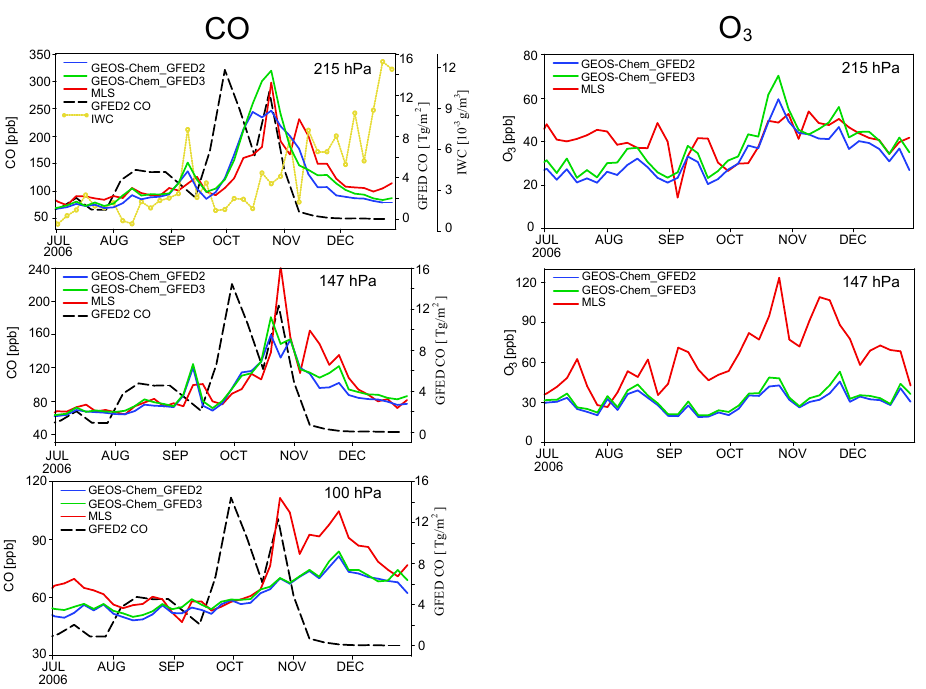
Fig. 9. Upper tropospheric CO and O 3 concentrations over the WCI (see Fig. 1) from July to December 2006 of MLS and GEOS-Chem CO and O 3 driven by GFED v2 and GFED v3 at 215, 147 and 100hPa. Also shown in the top left panel are GFED v2 8-day CO emissions and 215hPa MLS ice water content